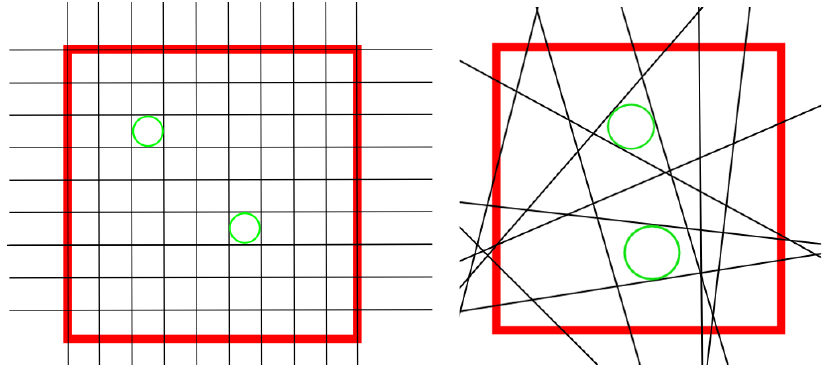
Figure 6 . On the l.h. side we plot a square intersected by a grid formed of n lines. The freely available space is of order 1 =n 2 . On the r.h. side we show a more generic intersection pattern. We expect the freely available size surrounding a generic point to be of the same order as for the case of a regular